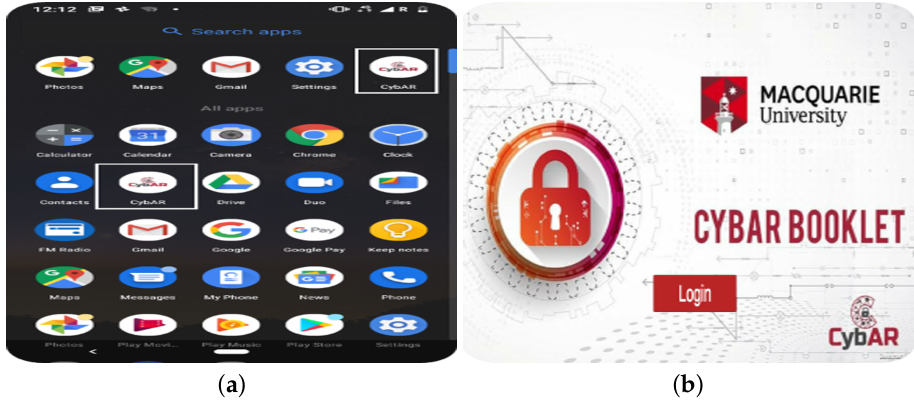
Figure 5. ( a ) CybAR app. ( b ) CybAR home